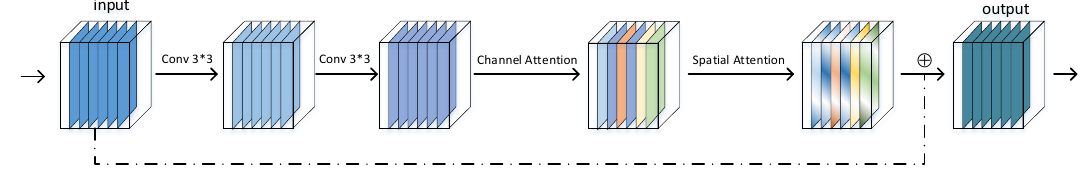
Figure 5. Structure of a basic convolution block with attention.